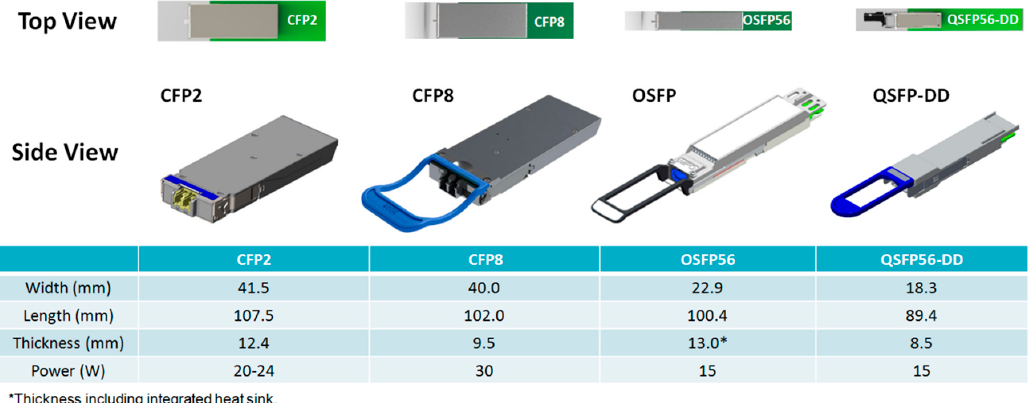
Figure 2. 400G pluggable coherent transceiver form factors. CFP: C form-factor, OSFP: octal small form factor, QSFP-DD: quad small form factor double density.